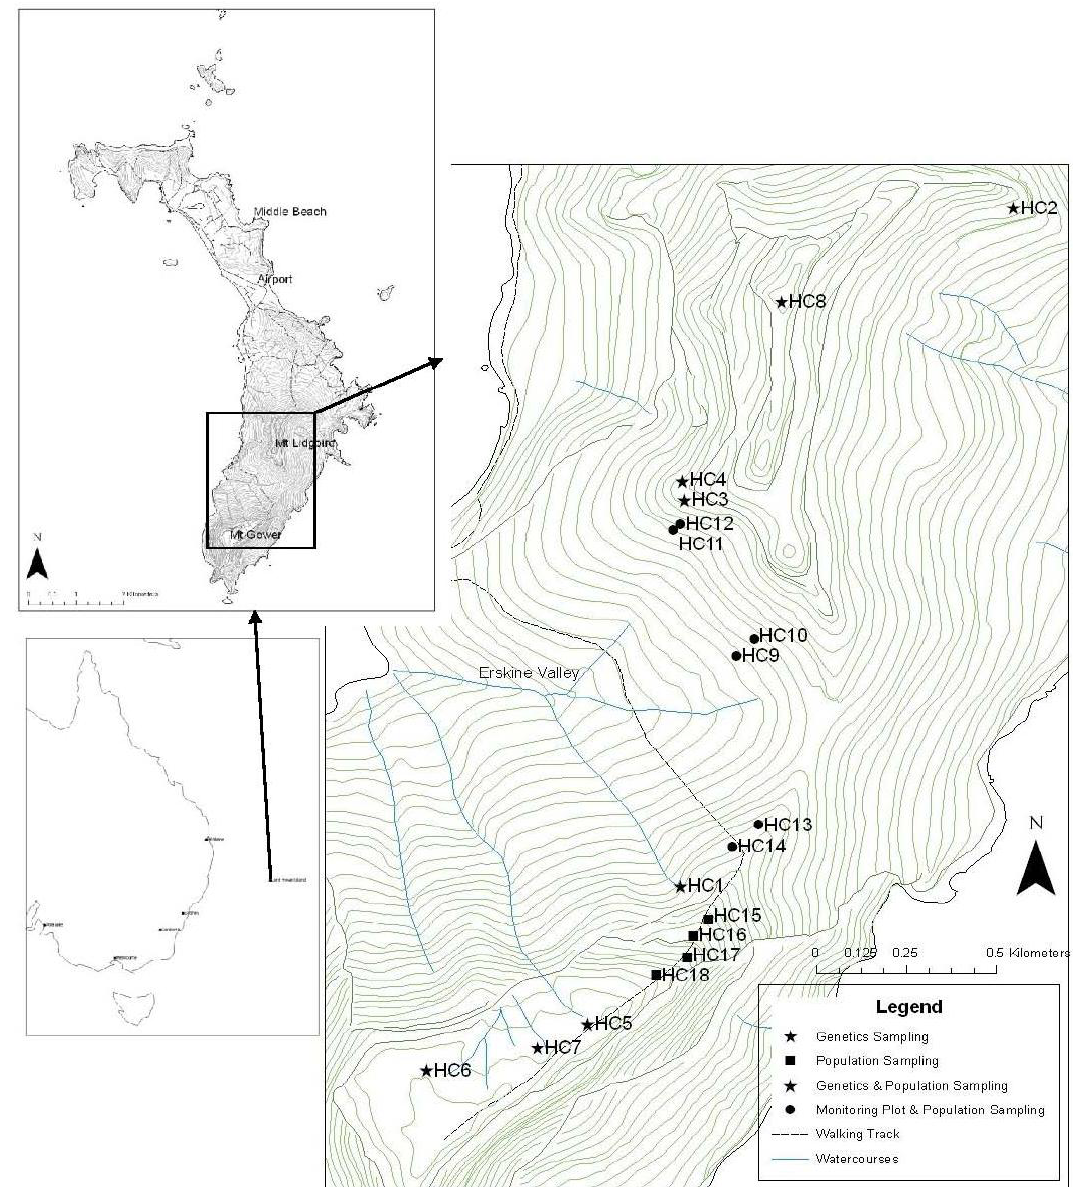
Figure 1. Map showing the location of Lord Howe Island in relation to Australia , highlighting the southern mountains, Mt Lidgbird (777 m) and Mt Gower (875 m). Enlargement map showing sites where H. canterburyana was sampled: genetics sampling sites, population demographic sampling sites, long term monitoring sites and combination sampling sites. The steep topography is indicated with 20 m contour lines from sea level to 860